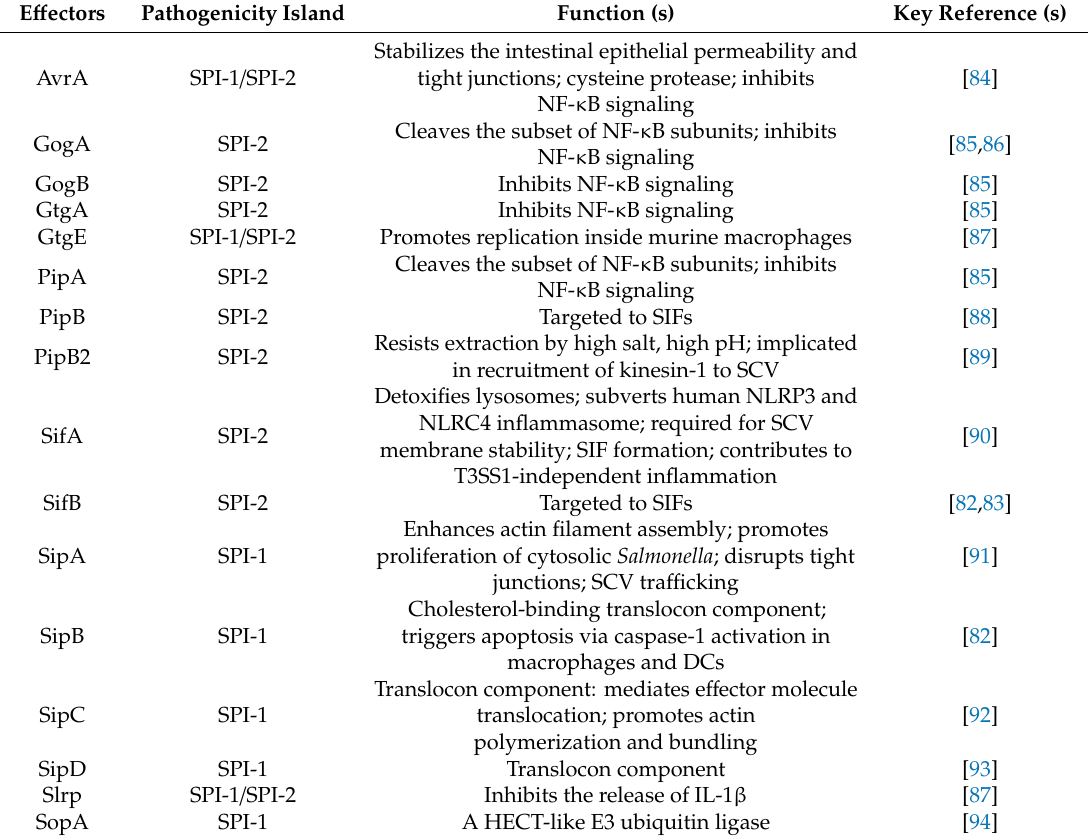
Table 1. The functions of SPI-1 / 2 e ff ectors in S . Typhimurium, S . Typhi, and S . Paratyphi A. E ff